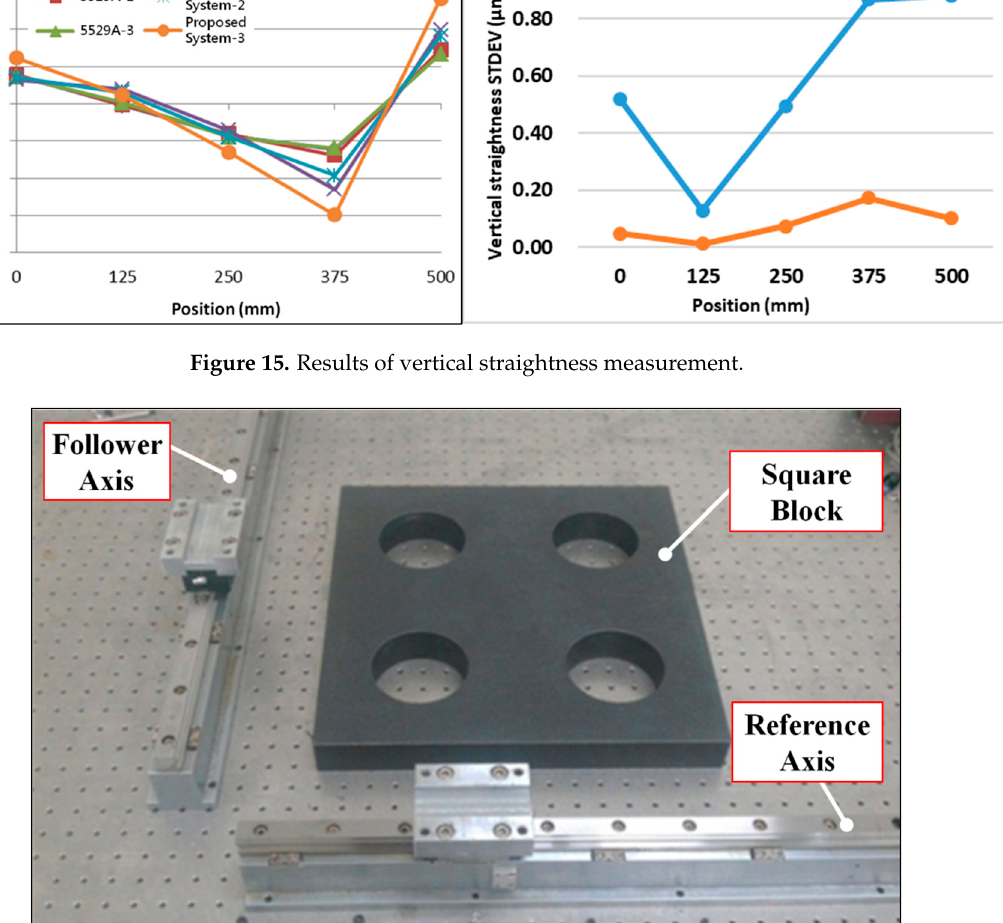
Figure 17. Verification setup of perpendicularity measurement using the proposed system. 4.4. Parallelism Measurement The verification of the proposed parallelism system was also conducted by using one square block, one dial indicator, and two linear guideways (both 400 mm) in a well air-conditioned laboratory. Figures 18 and 19 show the verification setup of the square block and the proposed system, respectively. The linear guideway was first aligned parallel to each other using a square block and then measured by the proposed system, as shown in Figures 17 and 18. The average parallelism error measured by the square block and the proposed system were 11.3 ± 0.5 µm and 11.2 ± 0.5 µm, respectively.